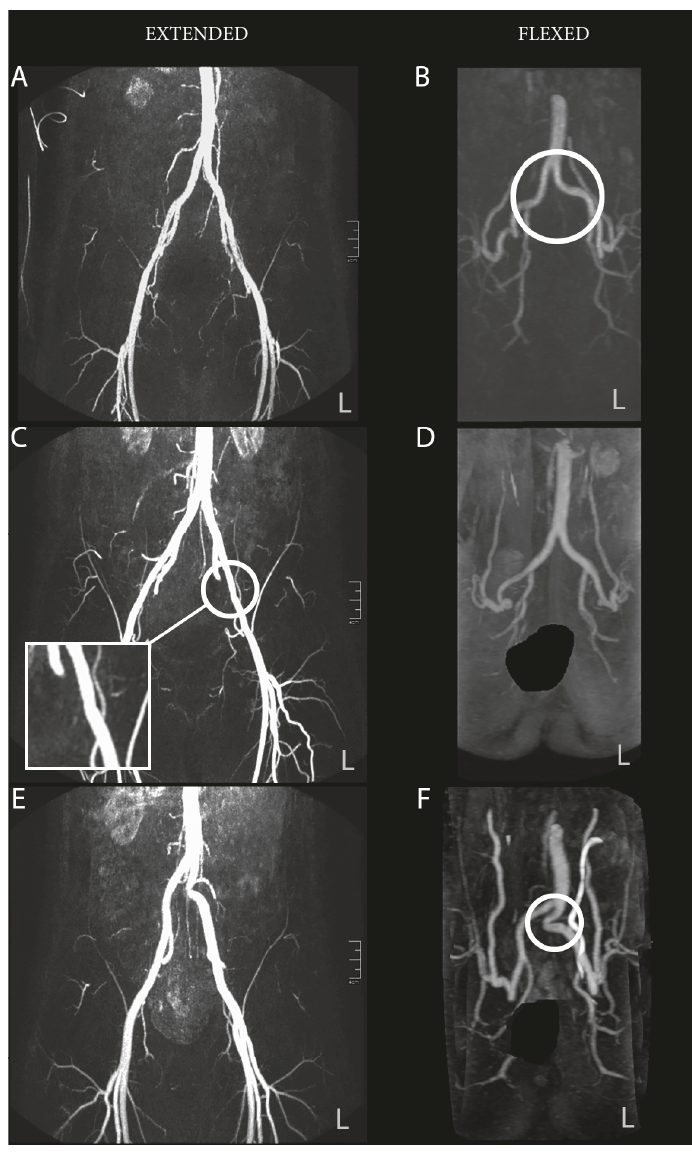
Figure 3: The first patient (A, B) shows subtle kinking, the second patient (C, D) shows an intravascular lesion, and the third patient (E, F) shows severe kinking. The circles denote the place of abnormality in the